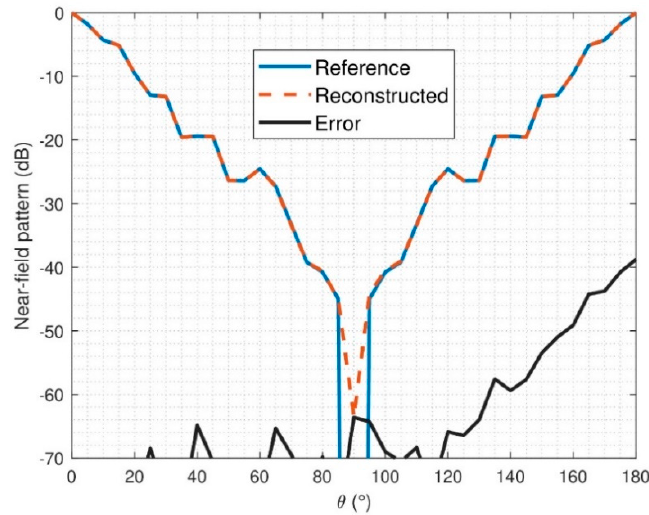
Figure 13. NF comparison of reference and retrieved electric field for noisy simulation, E θ , φ = 0°.